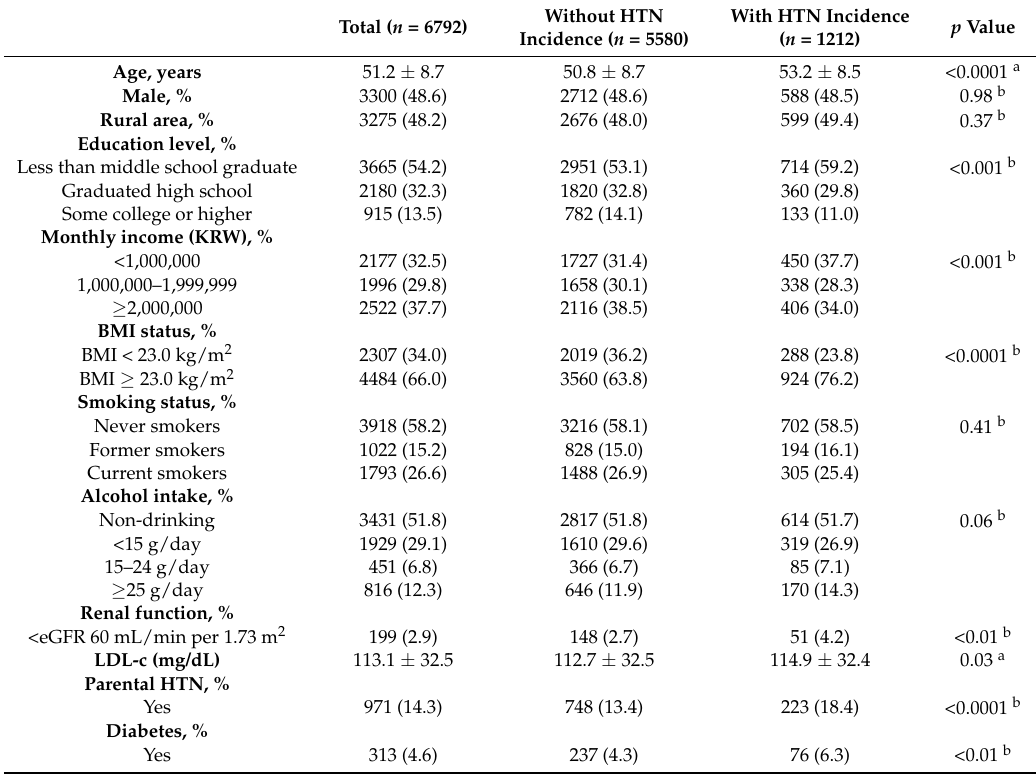
Table 1. Characteristics of the study subjects.